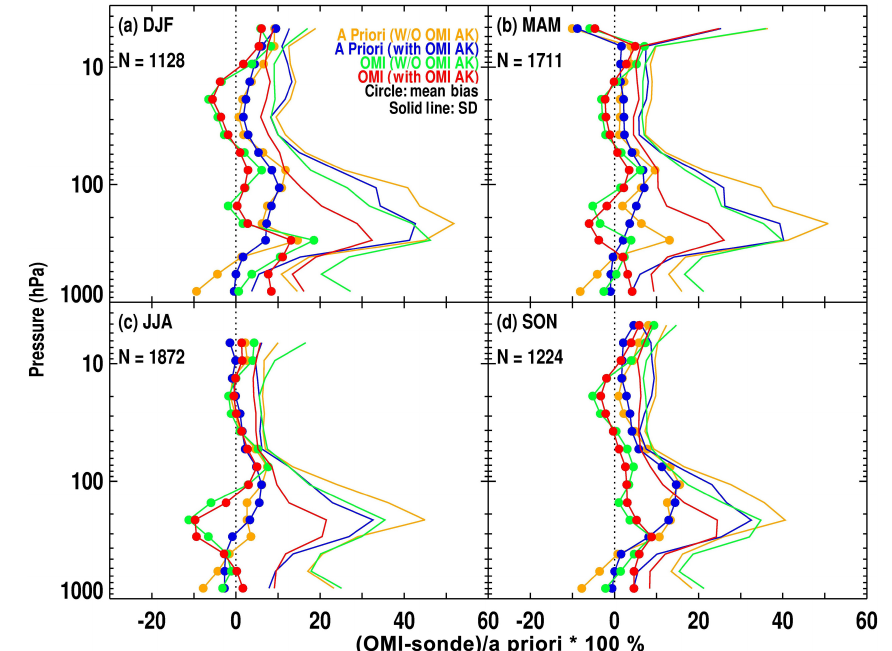
Figure 4. Same as Fig. 3c but for each individual season at 30–60 ◦